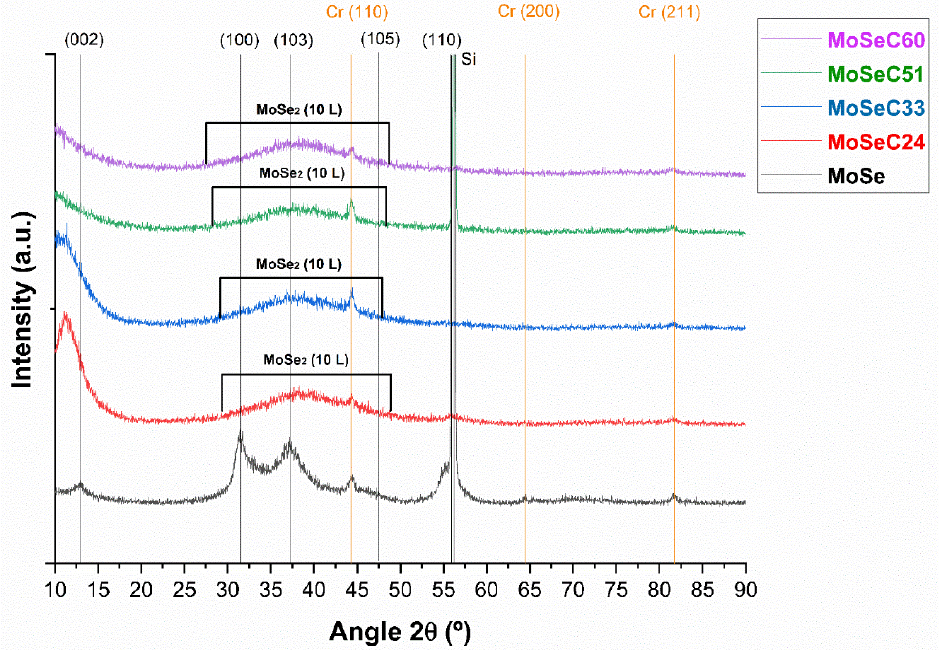
Figure 4. GIXRD diffractograms for all the Mo-Se-C samples.